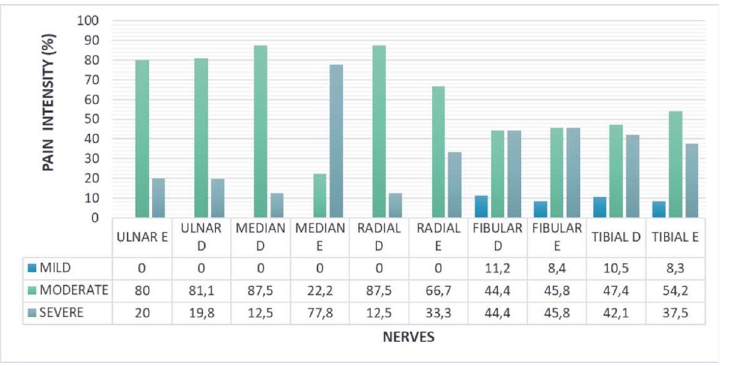
Fig 3. Percentage of pain intensity (VAS) in nerves of patients with neuropathic